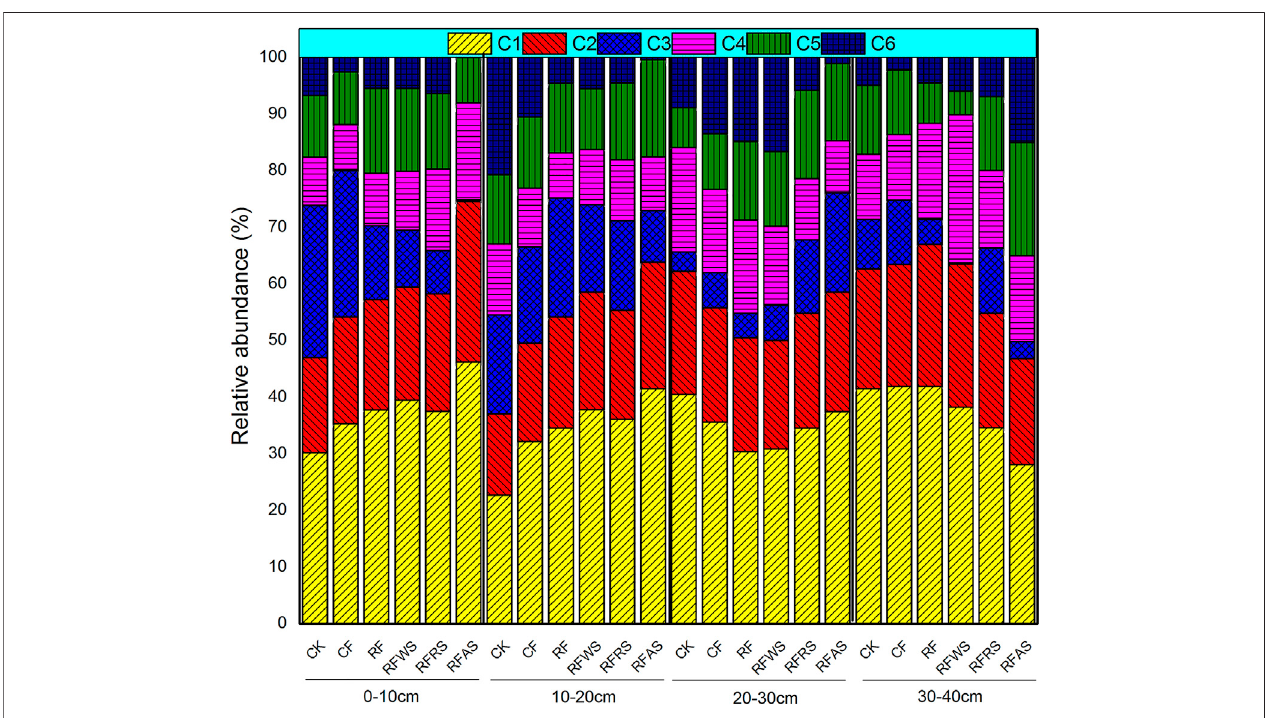
FIGURE 4 | Relative abundances of six fl uorescence components identi fi ed by EEM-PARAFAC modeling.